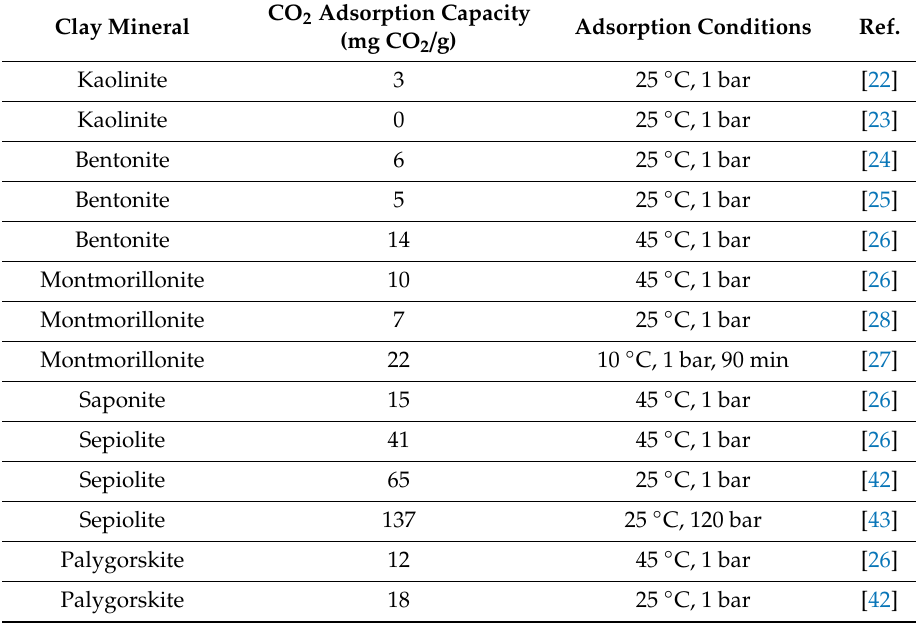
Table 1. CO 2 adsorption capacity of raw clay